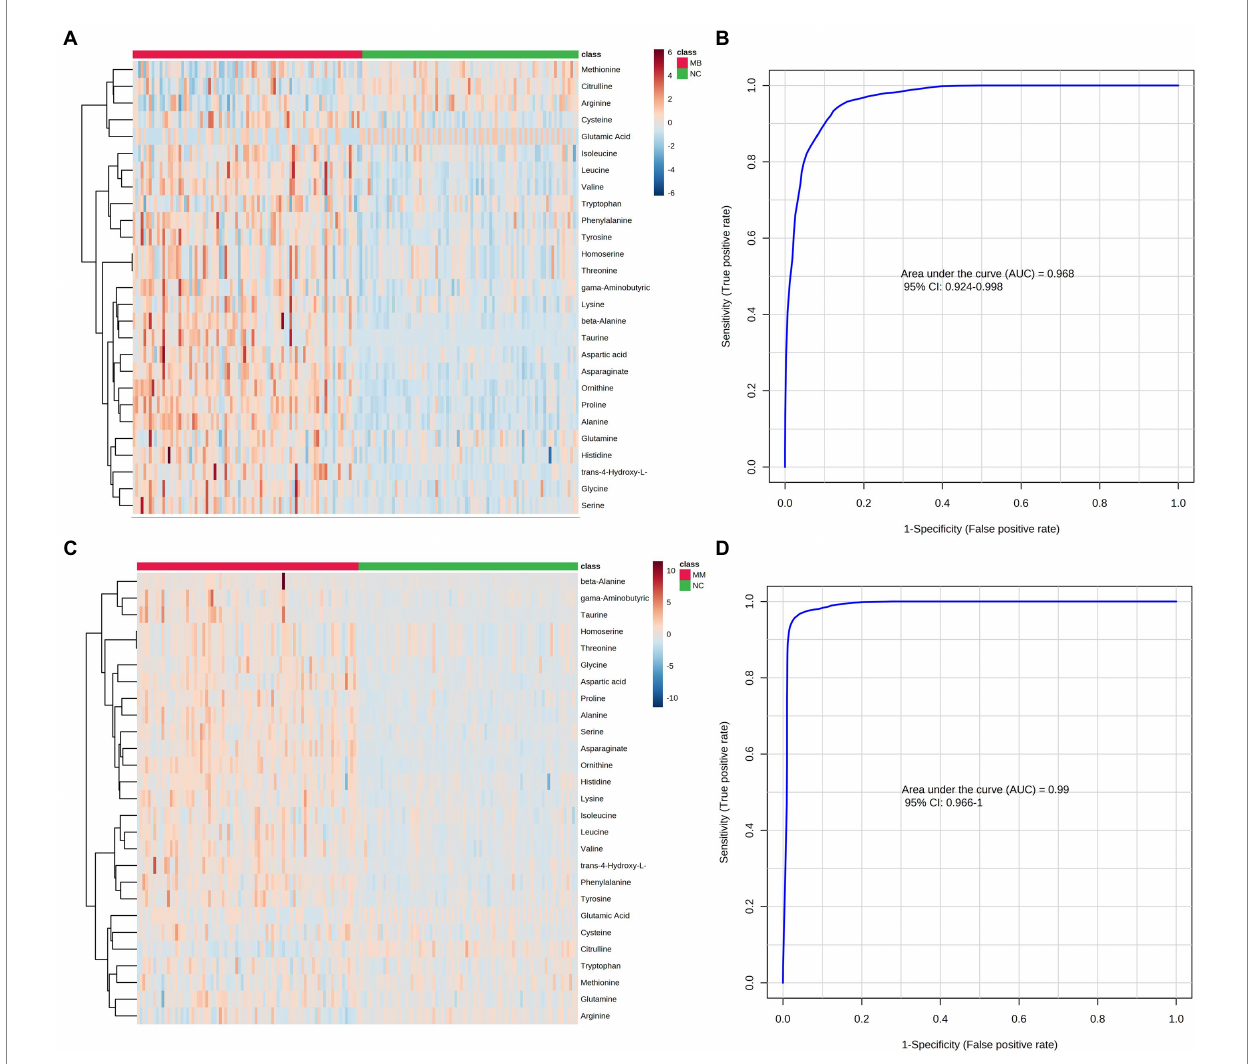
FIGURE 2 Differential expression of AAs concentration between the MB, MM and NC groups were plotted as heatmap ( A : MB vs. NC; C : MM vs. NC). Red represents a higher concentration, but blue represents a lower concentration in heatmap. The performance of AAs biomarkers in distinguishing NC, MB, and MM groups. ( B ) The ROC curve of 5 AAs (ornithine, asparagine, valine, citrulline, and cysteine) diagnostic panel between the MB and NC group. ( D ) The ROC curve of 5 AAs (ornithine, taurine, phenylalanine, citrulline, and cysteine) diagnostic panel between the MM and NC